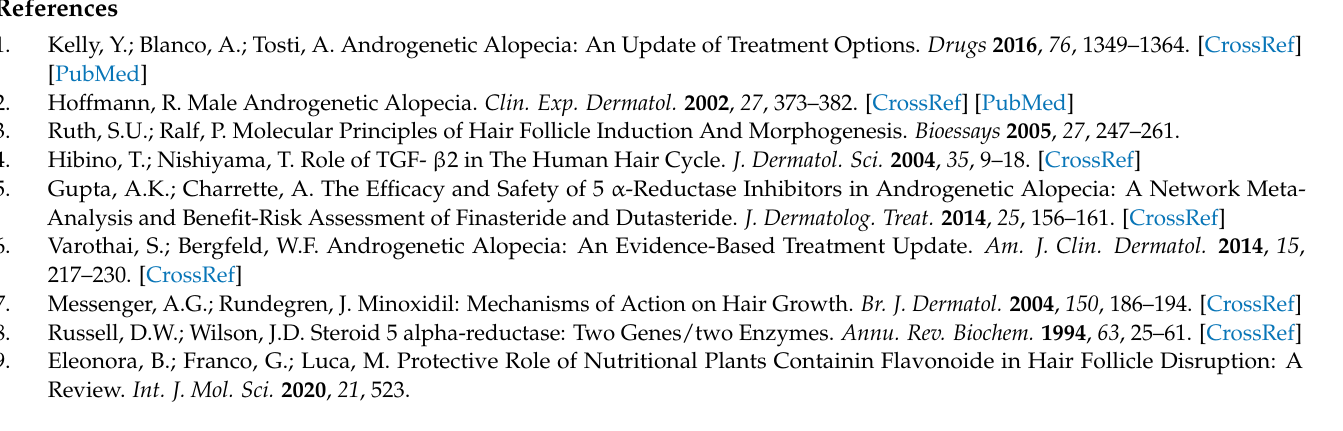
Figure S2: Five representative images for crown of the head obtained from using a high-resolution digital camera after 6, 12, and 18 weeks of use compared to before using the test